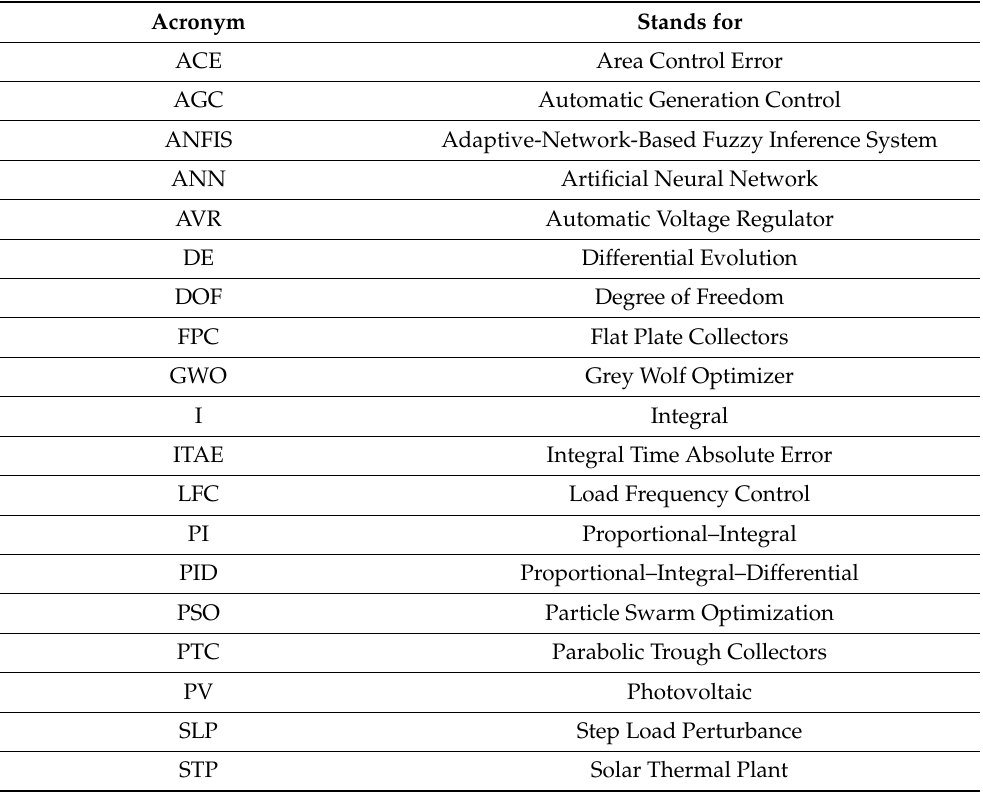
Table 1. Acronyms’ full forms.